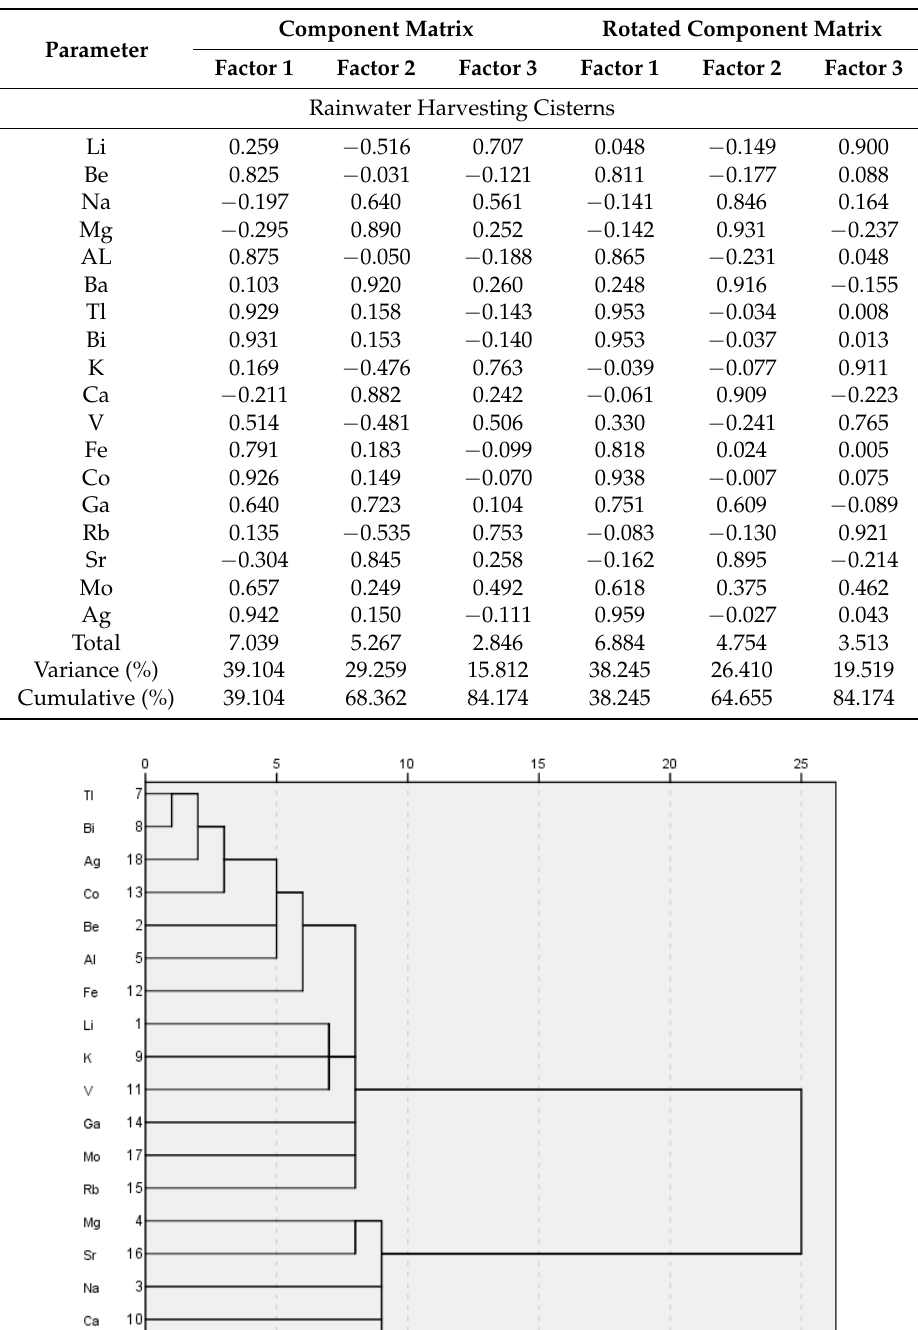
Table 5. Factor loading for selected heavy metals in rainwater harvesting cisterns (n = 74).